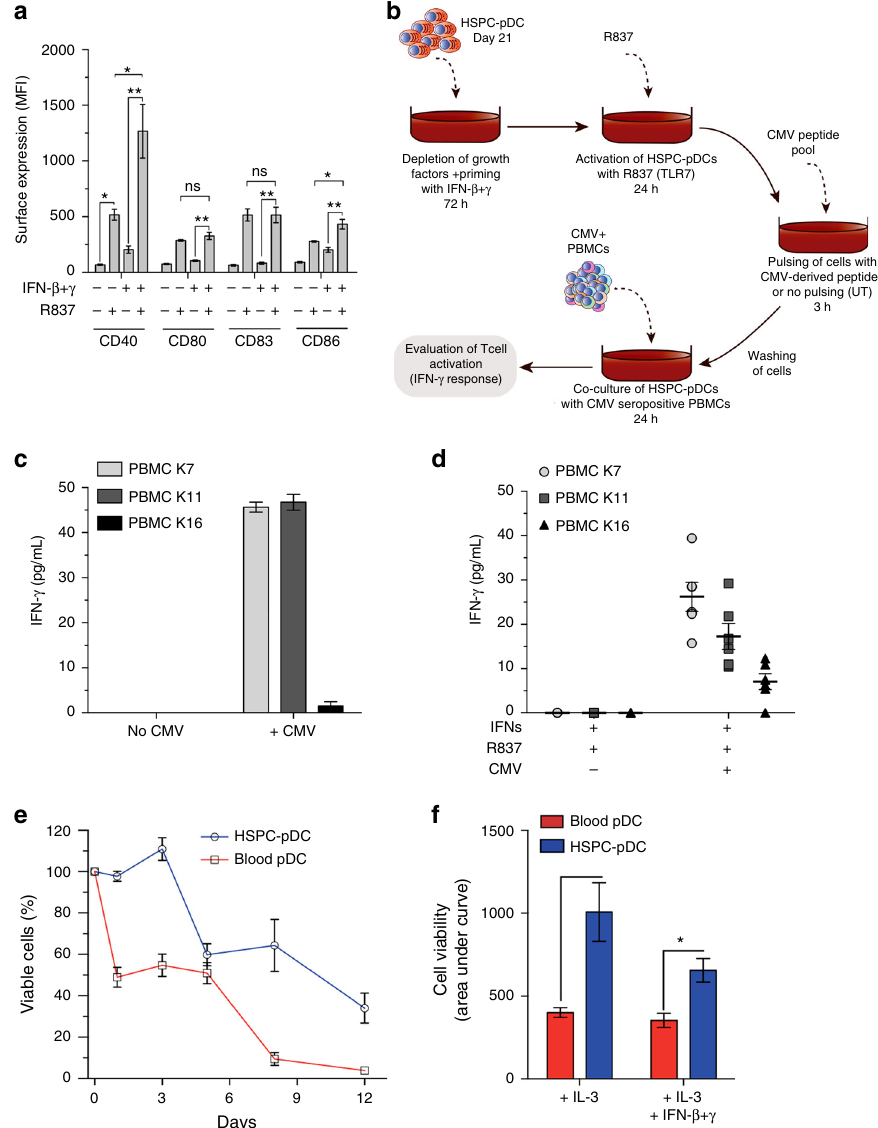
Fig. 5 HSPC-pDCs have the capacity to adopt an antigen-presenting phenotype. a Expression levels of the indicated maturation APC markers on IFN- primed/unprimed HSPC-pDCs at day 21 + 3 after stimulation with the TLR7 agonist R837. b Graphical illustration of the experimental setup for T cell stimulatory capacity of HSPC-pDCs. HSPC-pDCs (IFN-primed and TLR7-activated) were pulsed with a mix of peptides derived from CMV (CMV ProMix) or left untreated (UT). After 3 h, cells were washed and co-cultured with allogeneic PBMCs harvested from CMV-seropositive donors and T cell activity was subsequently evaluated by measuring levels of IFN- γ in the supernatant 24 h later. c Levels of IFN- γ produced by PBMCs from three CMV-seropositive donors after co-culture with pDCs loaded with CMV ProMix. d Levels of IFN- γ produced by the same three PBMC donors mixed in a 10:1 ratio with three HSPC-pDC donors (IFN-primed and TLR7-activated) for 3 h with or without a pulse of CMV ProMix. e Blood pDCs or HSPC-pDCs were cultivated for 1, 3, 5, 8, and 12 days in medium supplemented with IL-3. At each time point, the viability was assessed by fl ow cytometry. f Comparison of area under curve of HSPC-pDCs and blood pDCs in the different conditions tested. Data shown are ±SEM of three ( a – d ) or four ( e – f ) donors. Statistical analysis was performed using regular two-way ANOVA ( e , f ) followed by Bonferroni post hoc